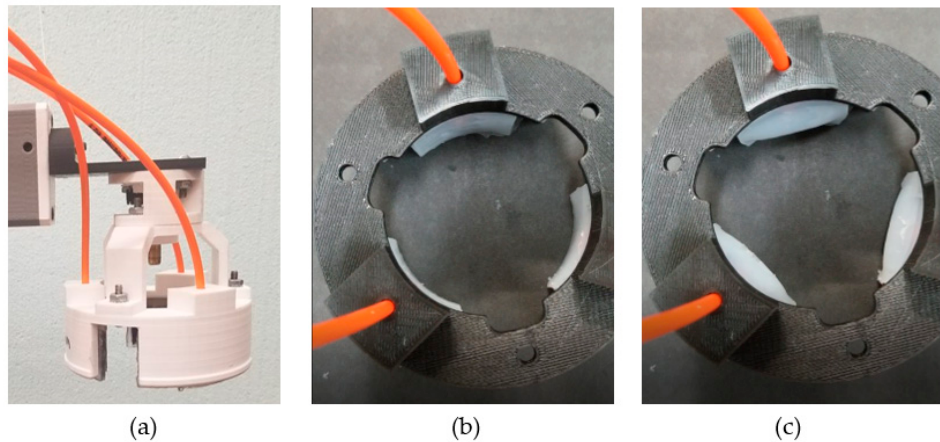
Figure 1. ( a ) Robotic end-effector with the elastomeric actuators inserted into gripper assembly (colored white). Top view of gripper ring in ( b ) deflated state and ( c ) moderate inflated state.